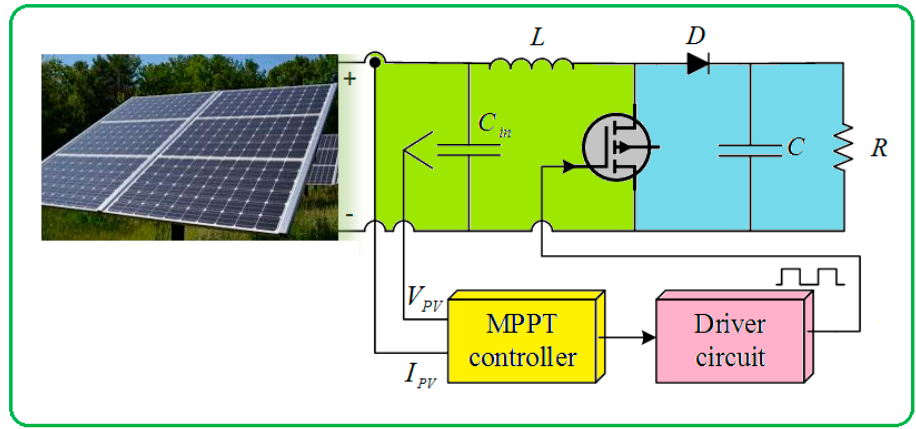
Figure 4. Block diagram of an ROA − based MPPT.